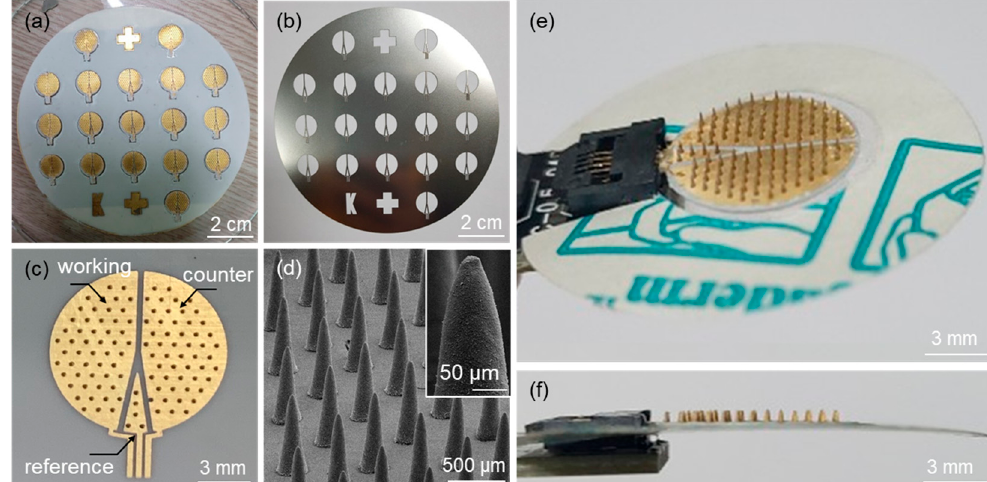
Figure 4. Optical images of ( a ) microneedle sensors fabricated on a 4-inch wafer size after the formation of Au electrodes, ( b ) the SUS stencil mask used for the Au sputtering process, and ( c ) the microneedle sensor separated from the substrate by laser dicing. ( d ) SEM image of an array of microneedles on the sensor. Optical images of ( e ) top and ( f ) side views of the microneedle sensor equipped with an adhesive film and the FCC